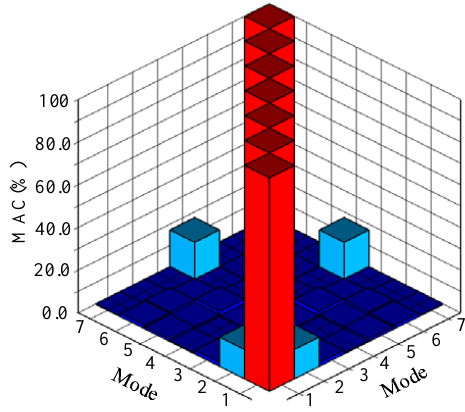
Figure 6. MAC of experimental mode.